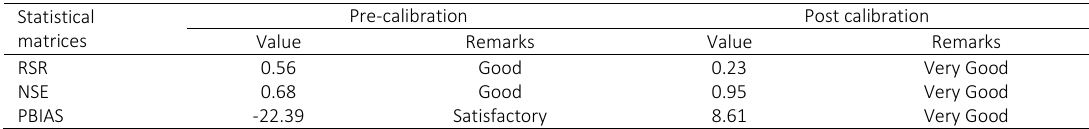
Fig. 4: Calibrated and uncalibrated simulated hydrographs against actual discharge Table 2: Statistical analysis of model performance